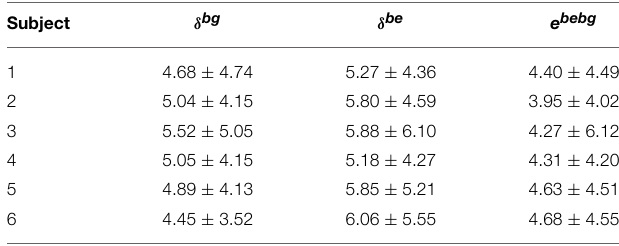
TABLE 3 | Errors obtained from behavioral model ( δ be k ) and BG ( δ bg k ) model independently and a comparison of the errors obtained from the 2 models ( e bebg k ). δ